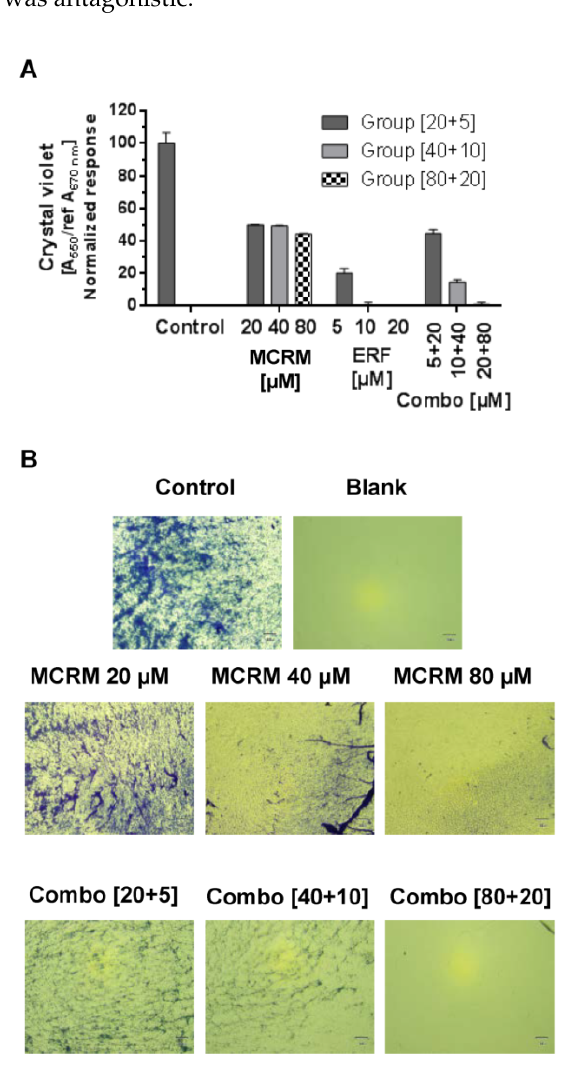
Figure 6. Effect of the synergistic combination [ratio 4:1] between micellar curcumin and erufosine on the biofilm formation of MRSA. Legend: ERF—erufosine; MCRM—micellar curcumin; ( A )—crystal violet absorbance of MRSA biofilm; ( B )—Morphological evaluation of MRSA biofilm (40 ×